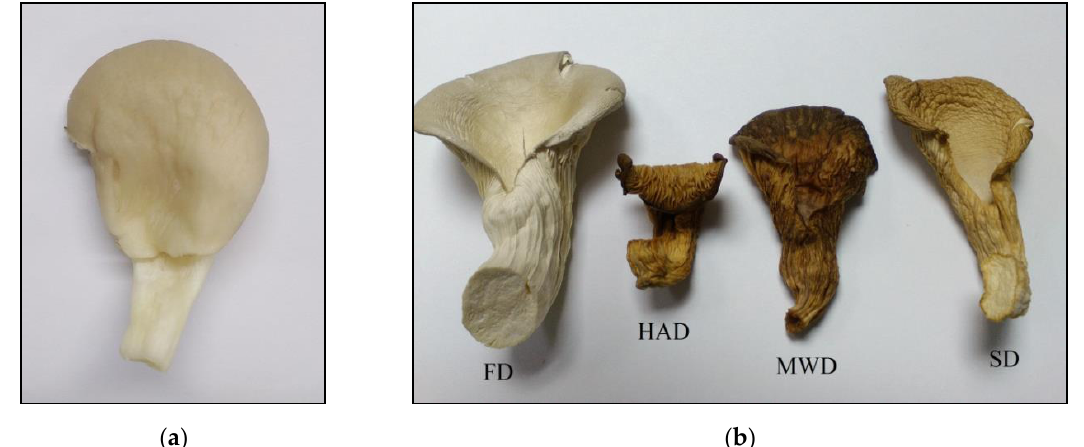
Figure 1. Macroscopic photos of fresh oyster mushroom ( a ) and after drying ( b ) FD—freeze drying;